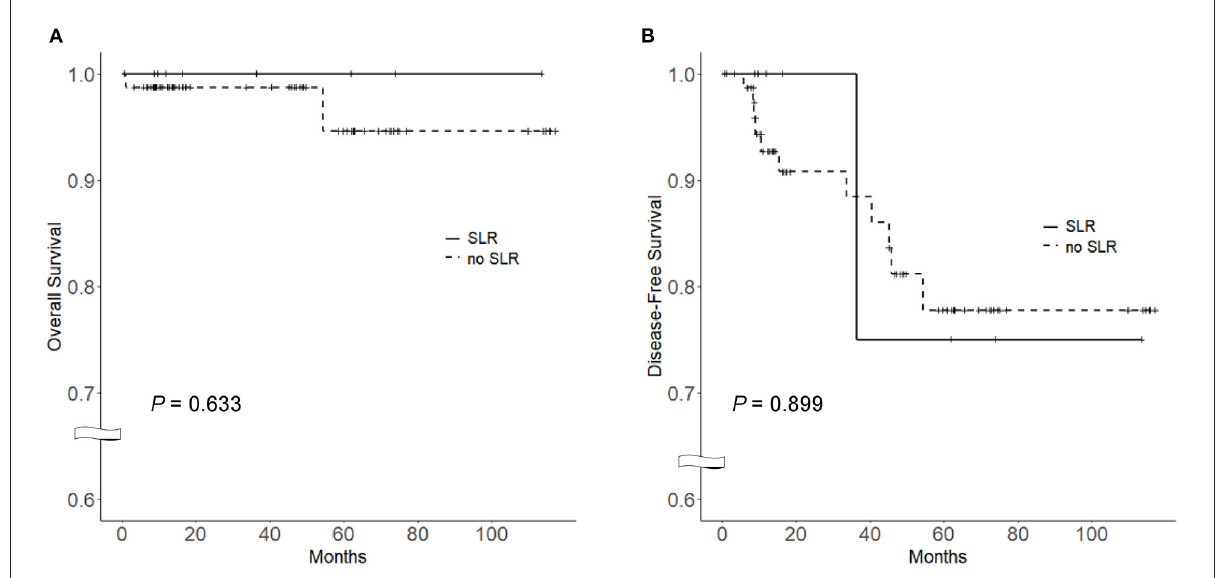
FIGURE2 Comparison of the Kaplan–Meier survival curves between SLR and non-SLR groups among NSCLC patients. (A) Overall survival curve, (B) Disease-free survival curve. Log-rank test was used for the analysis. SLR, sarcoid-like reaction; NSCLC, non-small cell lung cancer.